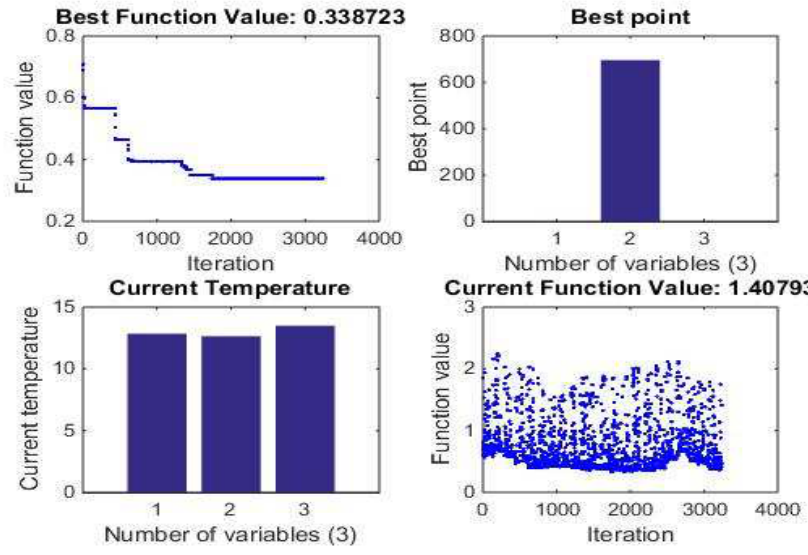
Fig. 10. Performance of Simulated Annealing Algorithm (R